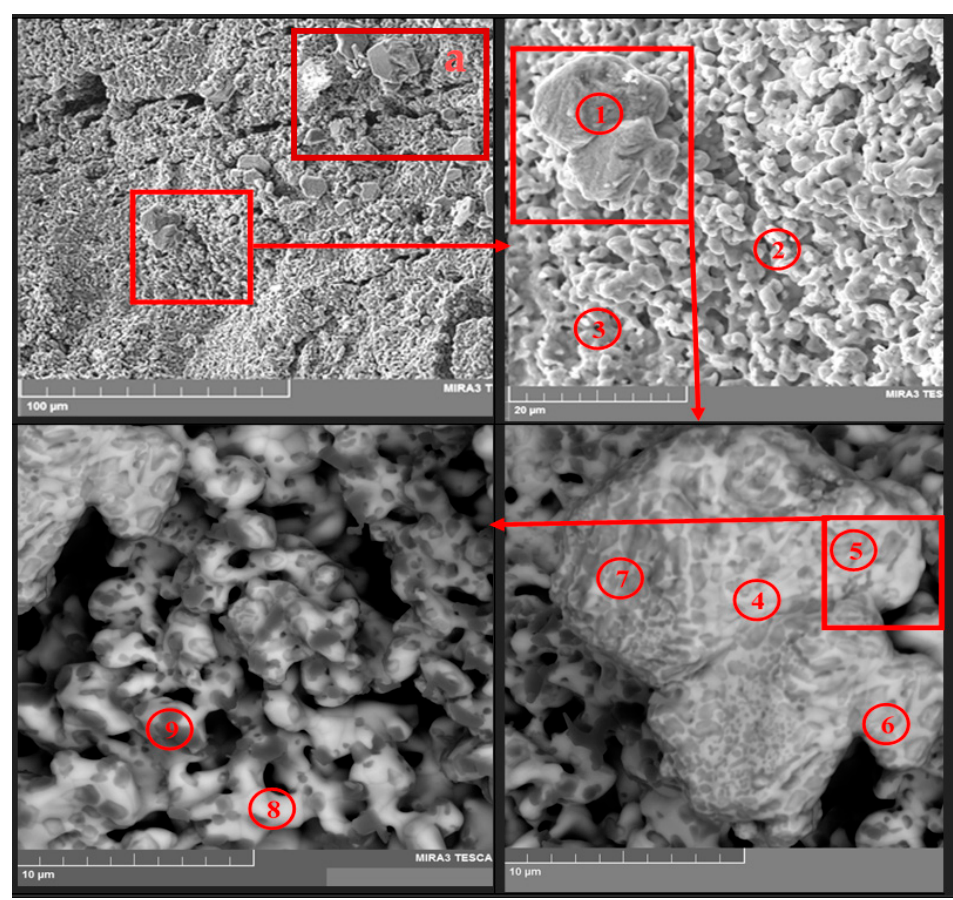
Figure 11. SEM images of the fragment of the La 2 O 3 -CeO 2 -Nd 2 O 3 pellet after the electrolysis and distillation of the electrolyte products. The numbers illustrate the regions of the sample taken for the elemental analysis (see Table 2). Table 2. Data on the elemental analysis of the REM oxides pellet fragment sampled from points illustrated in Figure 11, atomic %.